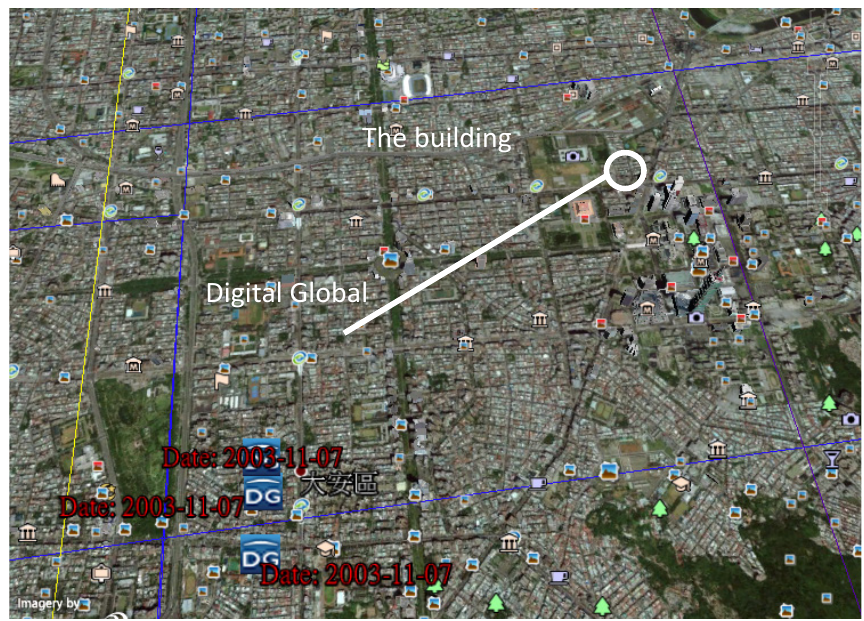
Figure A2. Find out Digital Global